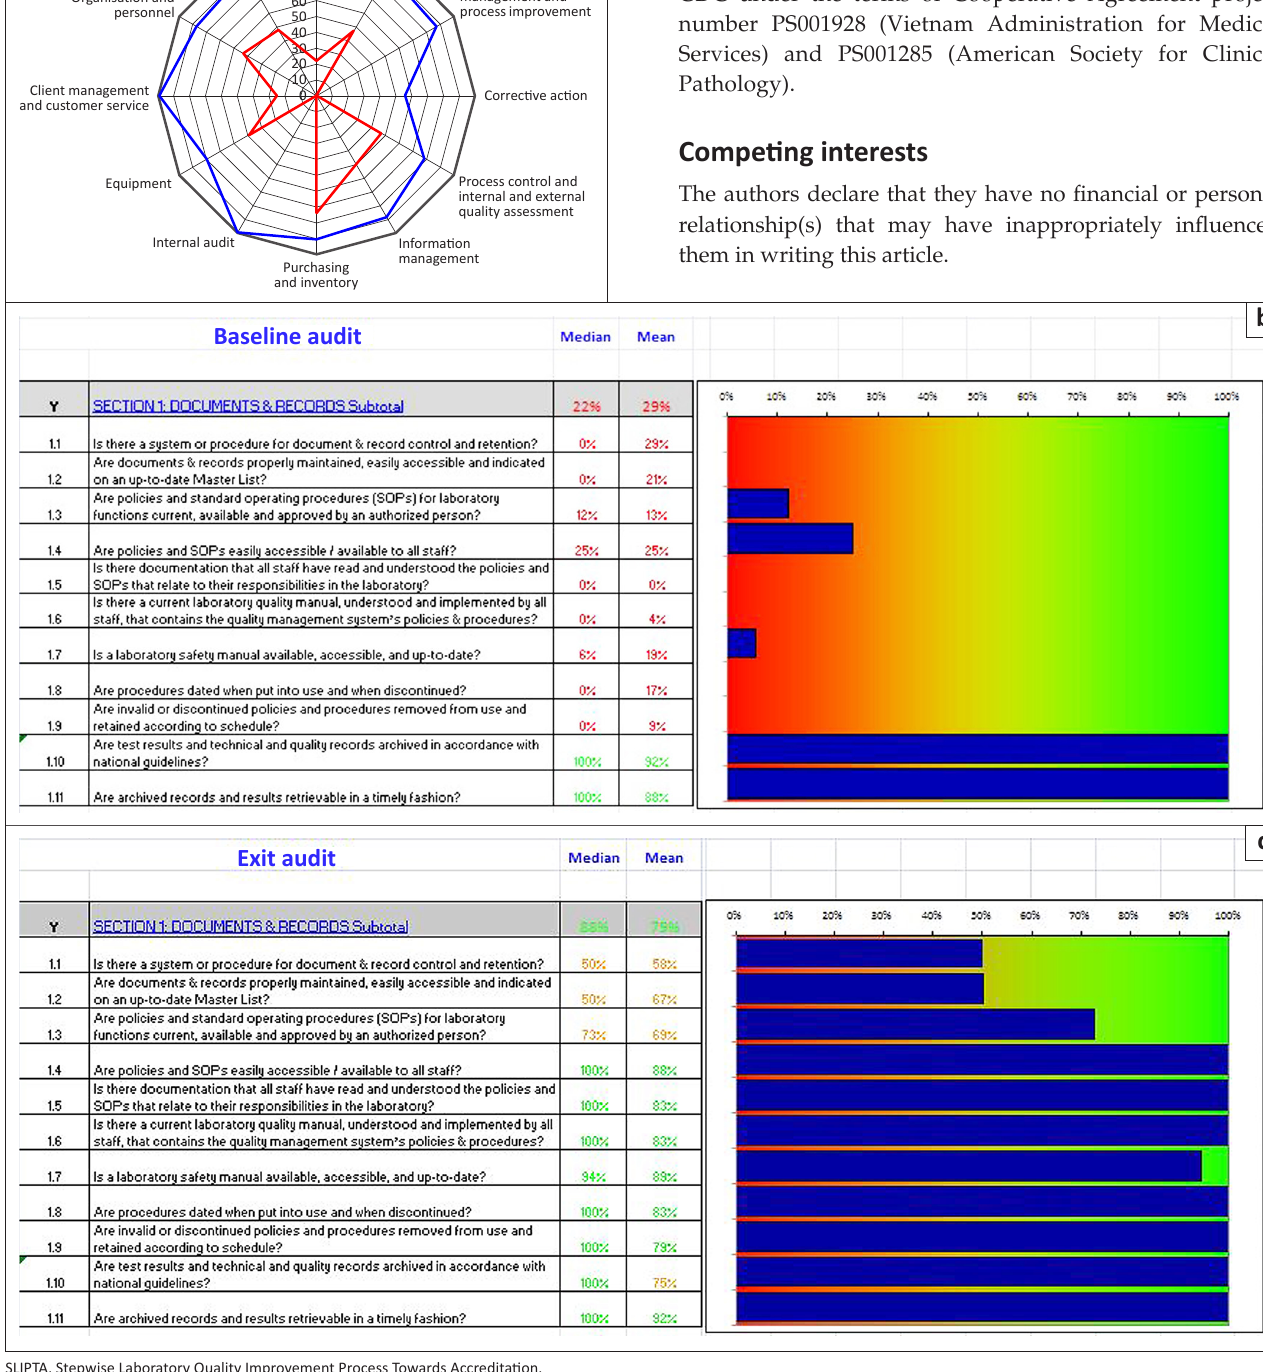
FIGURE 2: Visualised results for 12 laboratories in Vietnam using the SLIPTA e-Tool. (2a) Spider plot of combined baseline (May 2012) and exit (June to July 2013) audit median data for all 12 laboratory sites. (2b) Computer screen shot of baseline audit data for Section 1 (Documents and Records) of the SLIPTA checklist with bar-chart results. Colours indicate results that are acceptable (green), unacceptable (red) or partially compliant (yellow). (2c) Computer screen shot of exit audit data for Section 1 (Documents and Records) of the SLIPTA checklist with bar-chart